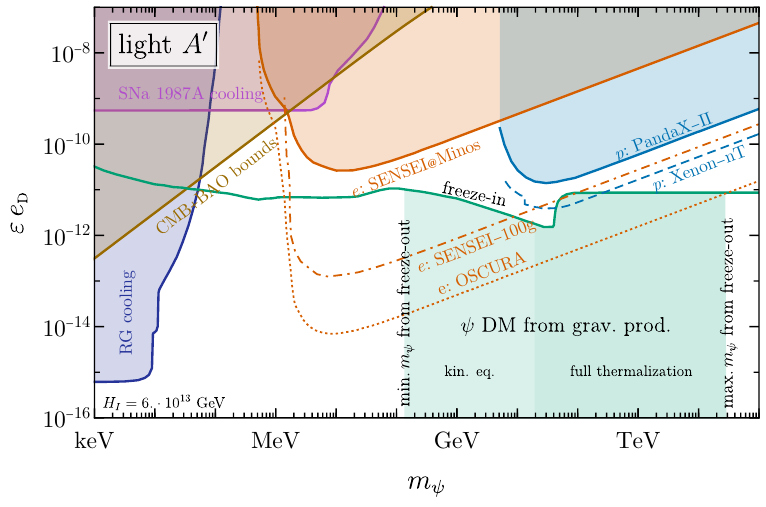
Figure 9. The green region shows the dark fermion parameter space, for m ψ (cid:29) m A 0 , that can be probed by the mechanism studied in this paper, assuming a kinetic mixing ε between the dark photon and the SM photon. The left and right boundaries are set by the mass range for which the dark fermion can be the dark matter (see figure 6) and the upper boundary corresponds to the standard freeze-in production of dark fermions from the Standard Model via kinetic mixing [18–20] (see appendix F for details). In the darker green region, the dark sector achieves full thermalization, whereas in the lighter green one it only reaches kinetic equilibrium (see section 3). With solid lines we outline the currently constrained regions, choosing representative bounds from electron recoils by SENSEI [50–52], and from nuclear recoils by PandaX-II [53, 54]. We plot near-future experimental reaches with dashed-dotted (SENSEI-100g [55]) and dashed (Xenon-nT [56, 57]) lines. The dotted line is the reach for OSCURA [58], which is more futuristic but relies on existing technology. We also include constraints from cosmological and stellar cooling arguments, as well as from observations of the SNa 1987A, so as to illustrate where our parameter space lies in the broader literature of millicharged